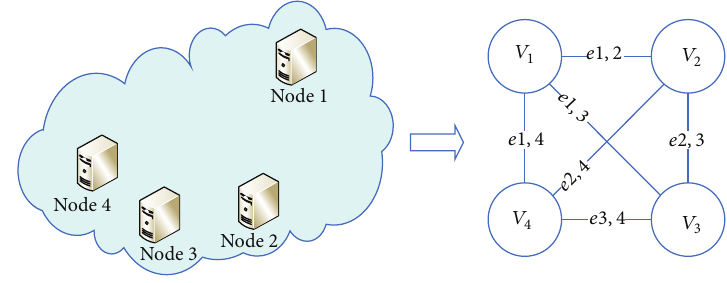
Figure 2: Weighted graph of cloud nodes.